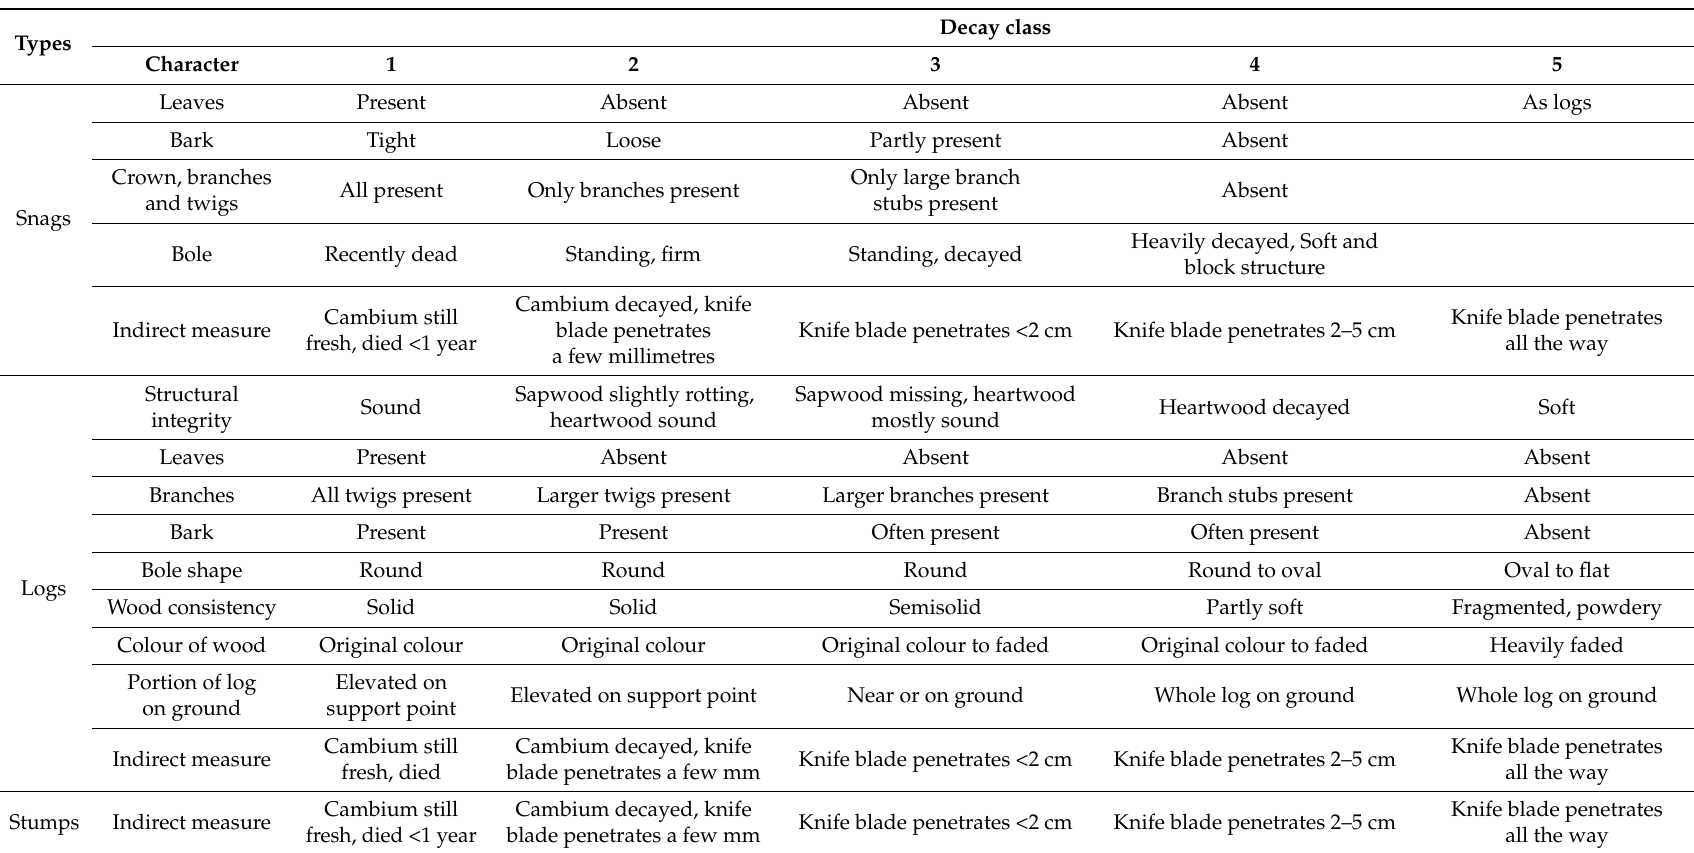
Table 3. Classification system of coarse woody debris (CWD) types in decay